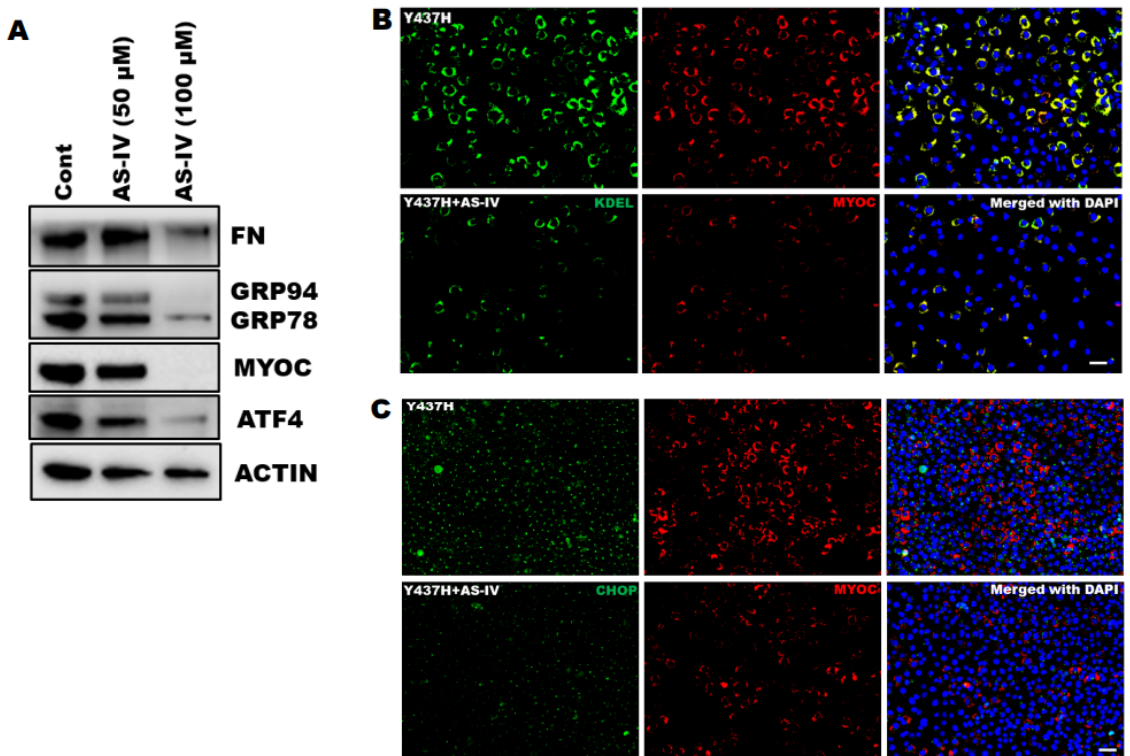
Figure 5. AS.IV treatment prevents mutant myocilin associated ER stress in TM cells. ( A ) TM3 cells stably expressing DsRed tagged mutant myocilin (DsRed-MYOC Y437H ) were treated with AS.IV (50 and 100 µ M) for 3 days. The cell lysates were analyzed by Western blot using ER stress markers (KDEL that recognizes GRP78 & GRP94, ATF4), ECM marker (FN) and myocilin. The AS.IV at 100 µ M concentration effectively reduced mutant myocilin induced ER stress and that is further associated with reduction in FN and intracellular accumulation of mutant myocilin ( n = 2 replicates). ( B , C ) TM3 cells stably expressing DsRed-MYOC Y437H were treated with AS.IV (100 µM) for 3 days. The cells were fixed and stained for KDEL ( B ) and CHOP ( C ). AS.IV treatment prominently reduced KDEL and CHOP staining which is associated with decreased DsRed expression in the cells indicating the reduction in the mutant myocilin accumulation ( n = 3 replicates). Scale bar 50µm.